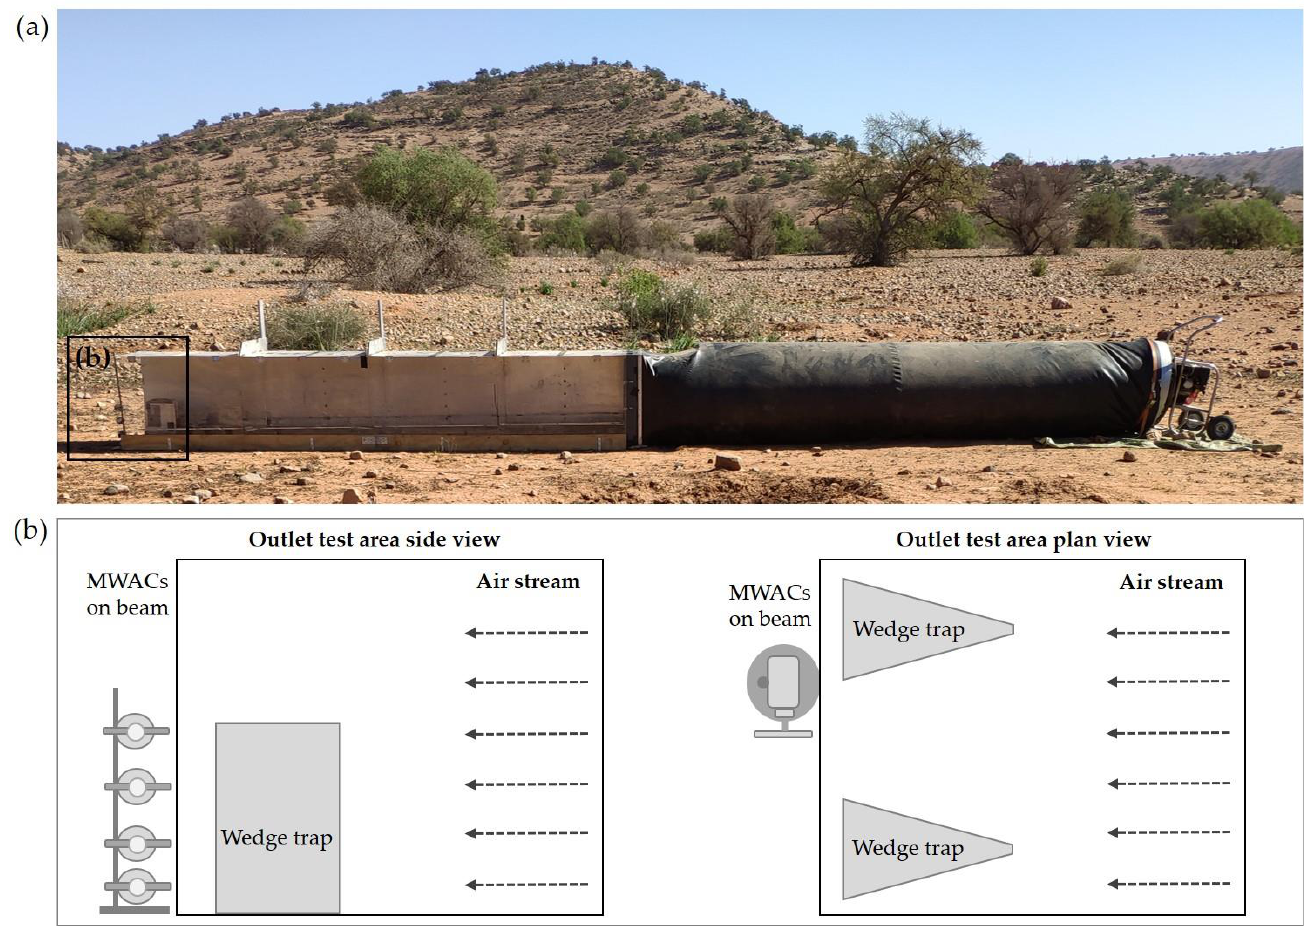
Figure 3. ( a ) mobile wind tunnel on site and ( b ) outlet area with collectors (modified from Marzen et al. 2020 [31]) .